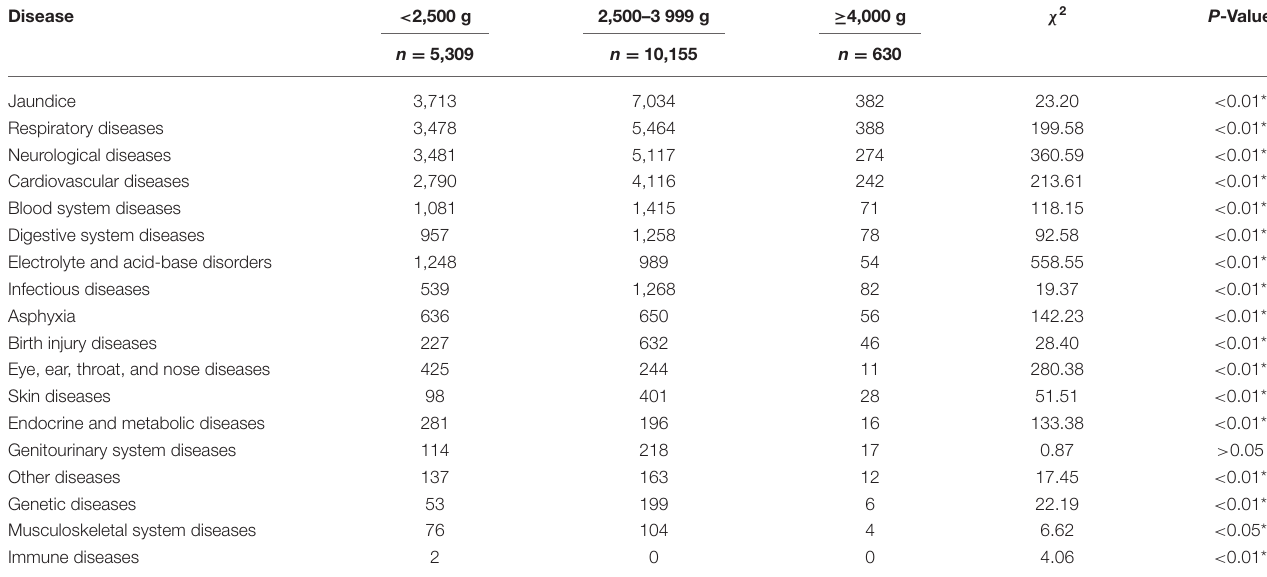
TABLE 10 | Prevalence of neonatal diseases in relation to birth weight. Disease